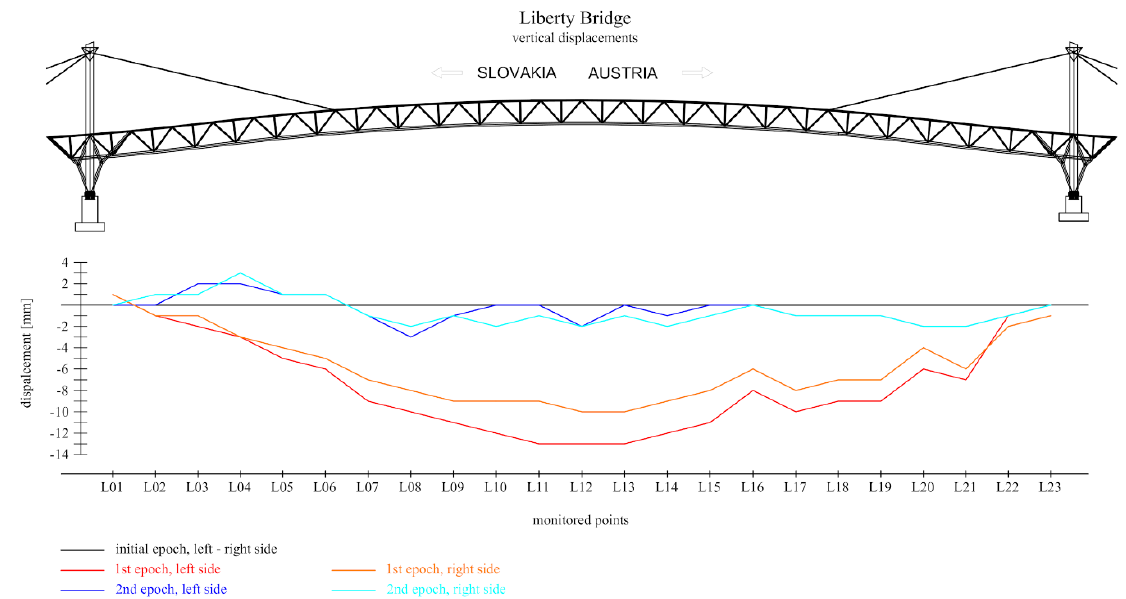
Figure 7. Vertical displacement of the monitored points obtained by terrestrial laser scanning (TLS).